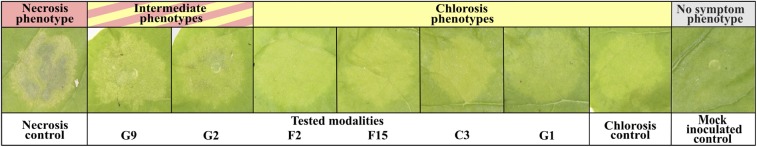
Visual observation of controls and tested-strains of the first data set at 3 dpi. Two phenotypes for the tested-strains (strains G9, G2, F2, F15, C3, G1) were identified as intermediate and chlorosis phenotypes.